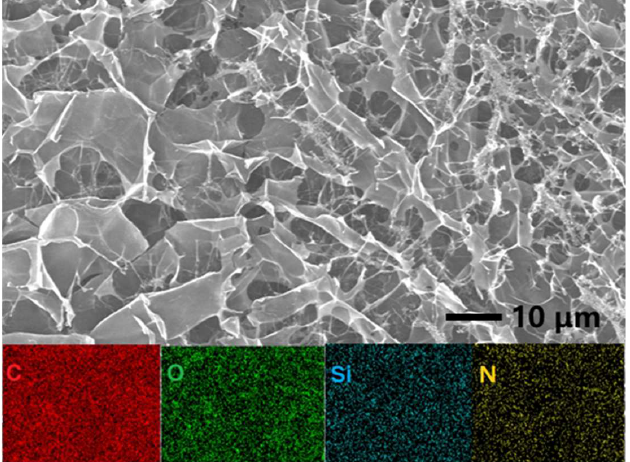
Figure 2. SEM image of freeze-drying of the hydrogel solution, and EDS elemental mappings of C, O, Si, and N,